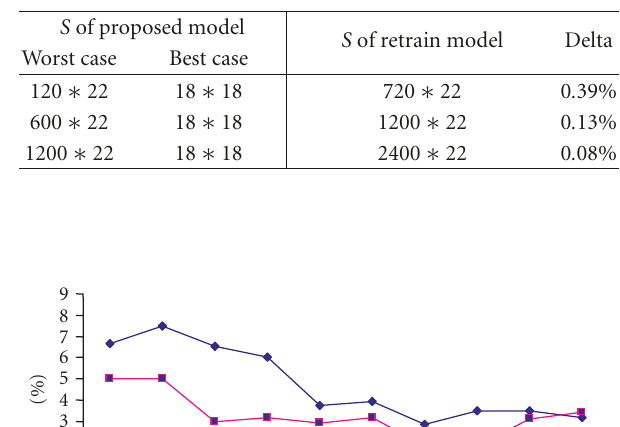
Table 3: Accuracy versus storage requirements for one camera in- put.